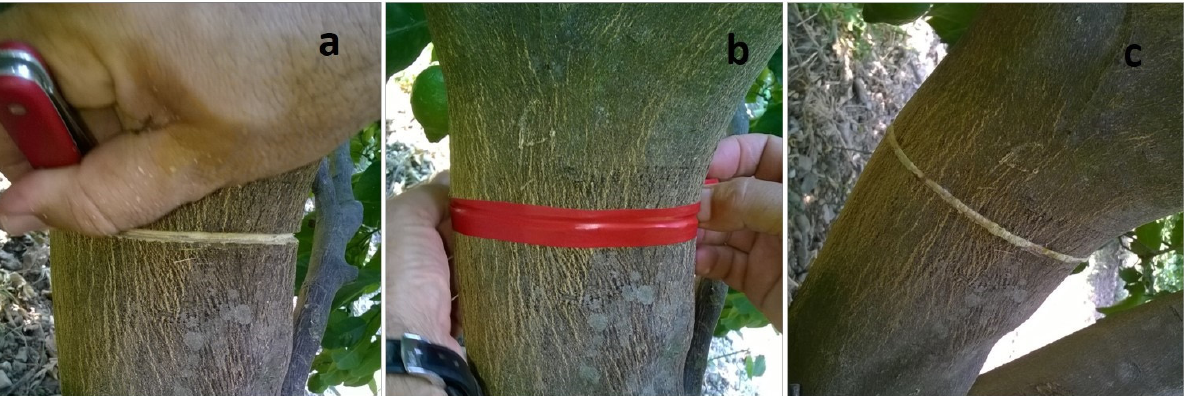
Figure 1. Phases of the girdling operations: ( a ) girdle making; ( b ) covering the cut with air-permeable but water-resistant grafting tape; ( c ) wound healing status 1 month after the conclusion of the study.